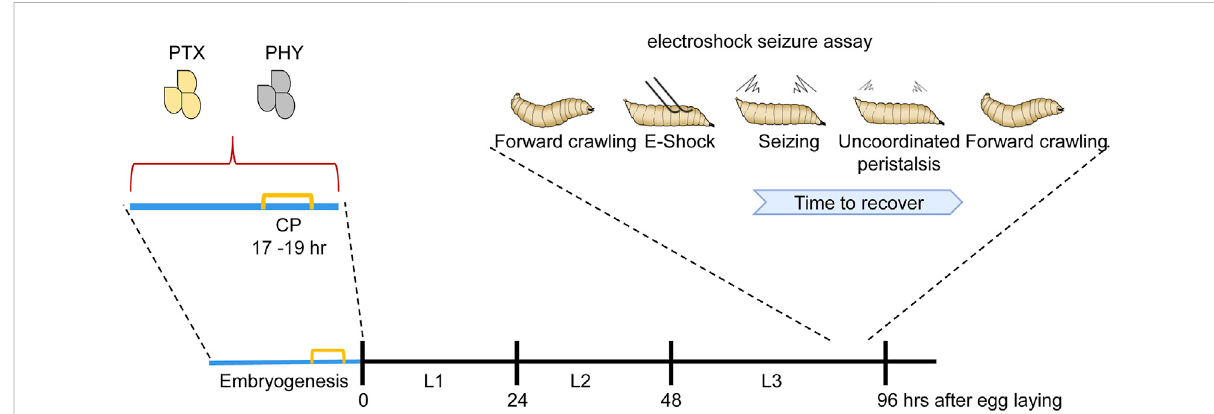
FIGURE 1 Manipulation of activity during the Drosophila locomotor CP is suf fi cient to induce a seizure-like phenotype. Manipulating activity during embryogenesis, in this instance via feeding gravid females either picrotoxin (PTX, excitatory) or phenytoin (PHY, inhibitory), is suf fi cient to disturb neuronal activity during theembryonic CP (indicatedin yellow). Activity manipulation during thisCP results in an unstable locomotor network. Thus, inresponsetoelectroshock,wall-climbingthirdinstarlarvae(L3),5 dayslaterandwhennotraceofdrugispresent,exhibitanextendedseizure- like bout [for more details of this behavior see (Marley and Baines, 2011)]. L1 and L2 are fi rst and second instar stages,